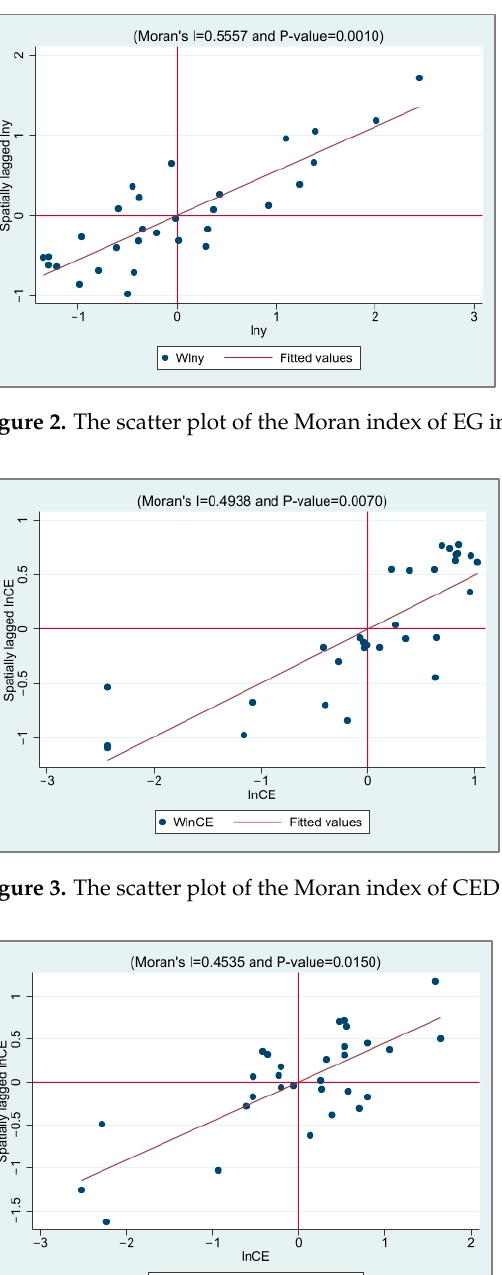
Figure 1. The scatter plot of the Moran index of EG in 2000.